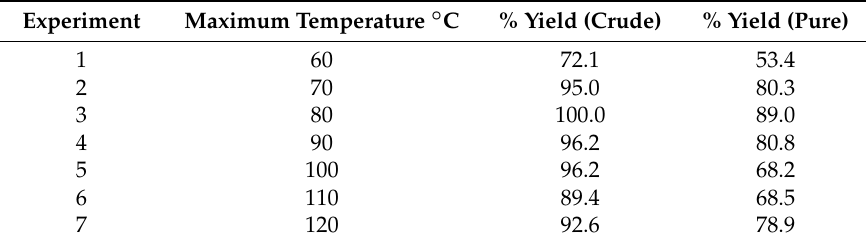
Table 1. Optimization of microwave conditions using benzyl azide and ethynylbenzene, CuSO 4 , and sodium ascorbate in t -BuOH/H 2